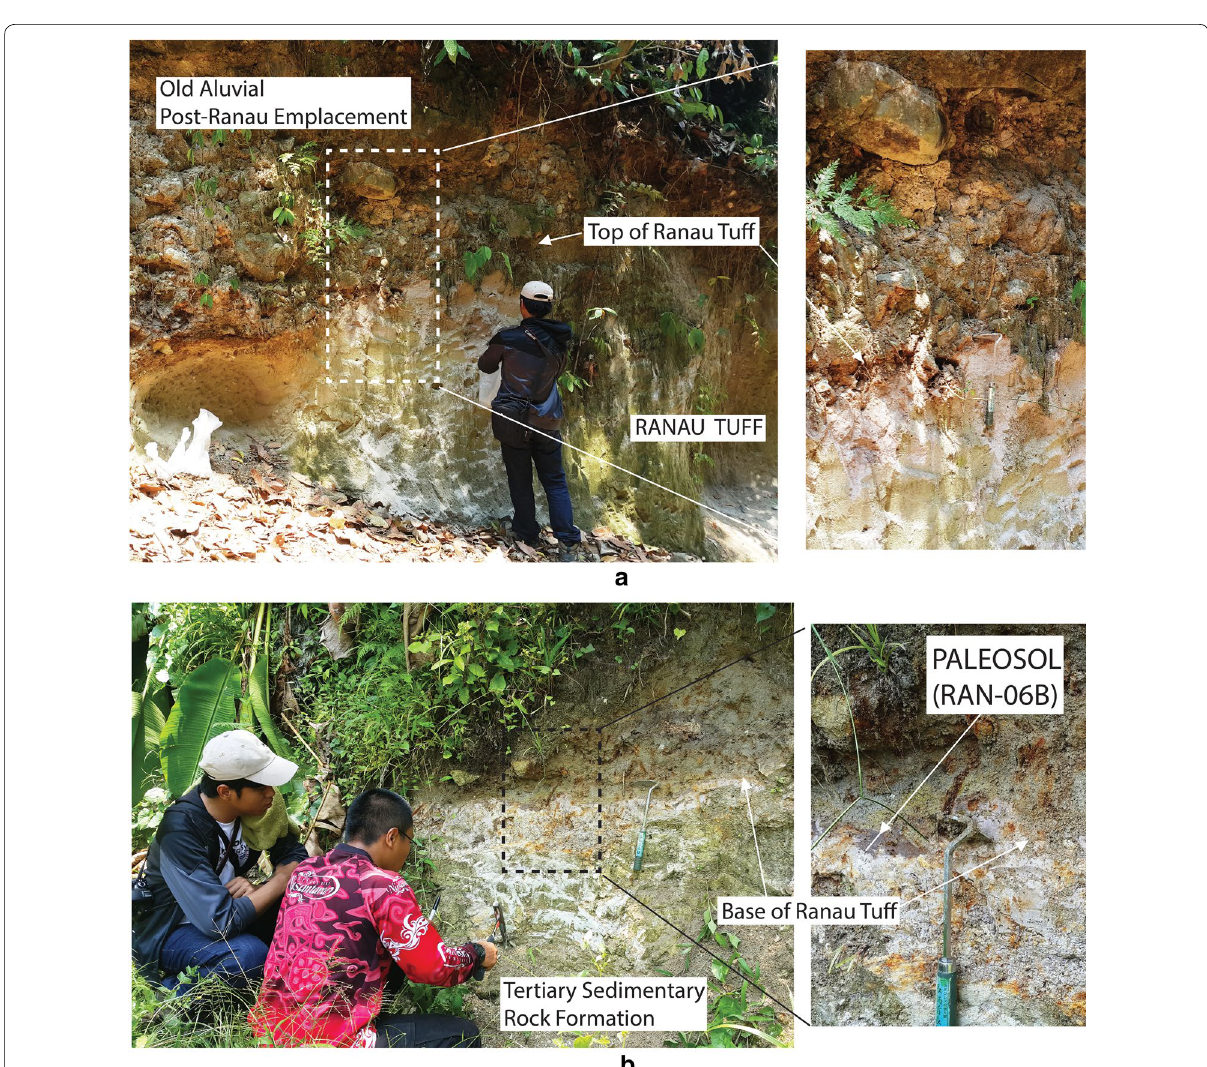
Fig. 9 Exposure of the distal Ranau Tuff along the trace of the Pauh Fault, 20 km from the eruptive center near Sukabumi village (Lat,Lon: 103.88004). a Top of Ranau Tuff overlain by old alluvial deposit. b Base of Ranau Tuff overlying the Tertiary sandstone. RAN-06B sample is collected from a thin, light gray